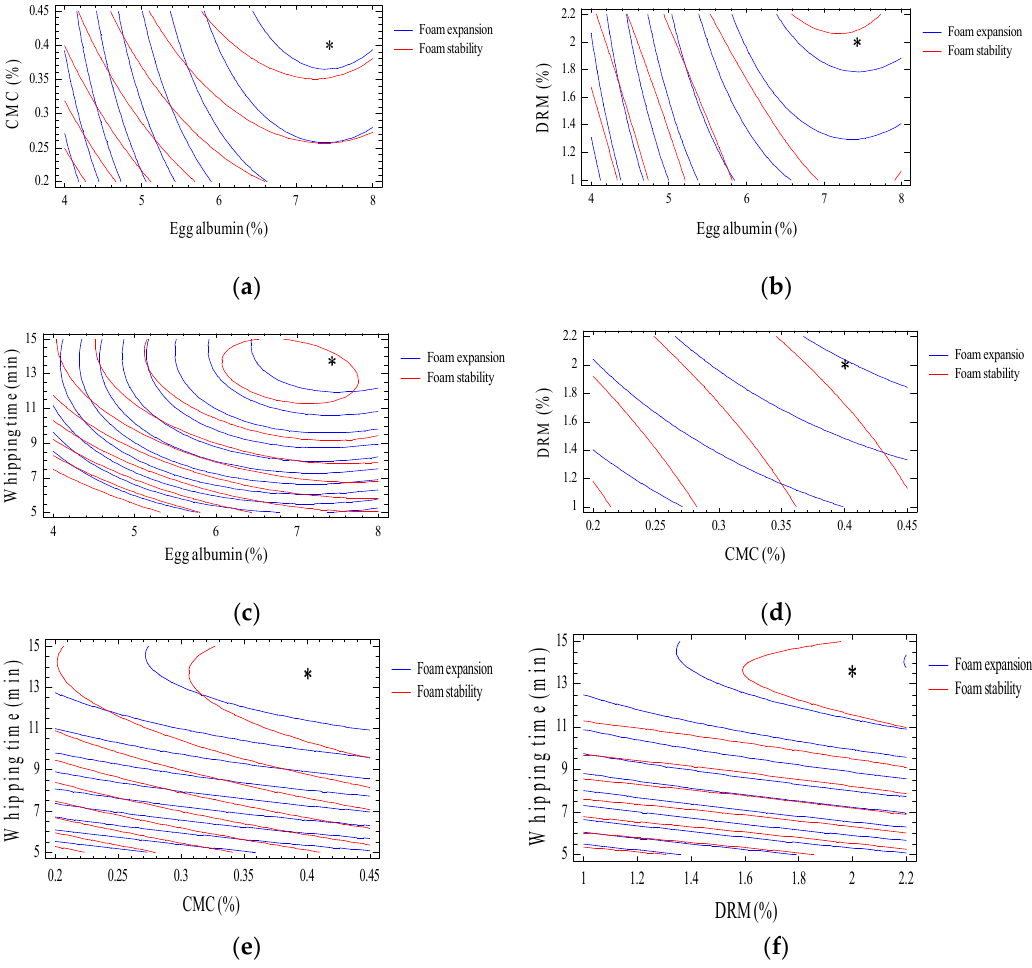
Figure 3. Overlay plot displaying the level of input variables and expected response values. ( a ) DRM 1.5%; whipping time 10 min. ( b ) CMC 0.3%; whipping time 10 min. ( c ) CMC 0.3%; DRM 1.5%. ( d ) Egg albumin 6%; whipping time 10 min. ( e ) Egg albumin 6%; DRM 1.5%. ( f ) Egg albumin 6%; CMC 0.3%. * is optimal